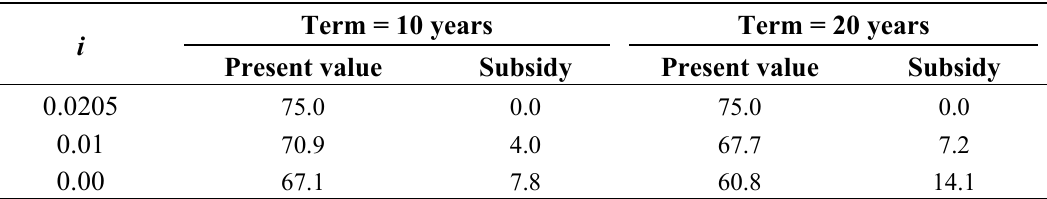
Table 11. Other incentive schemes: A subsidy to interest rate (£M).